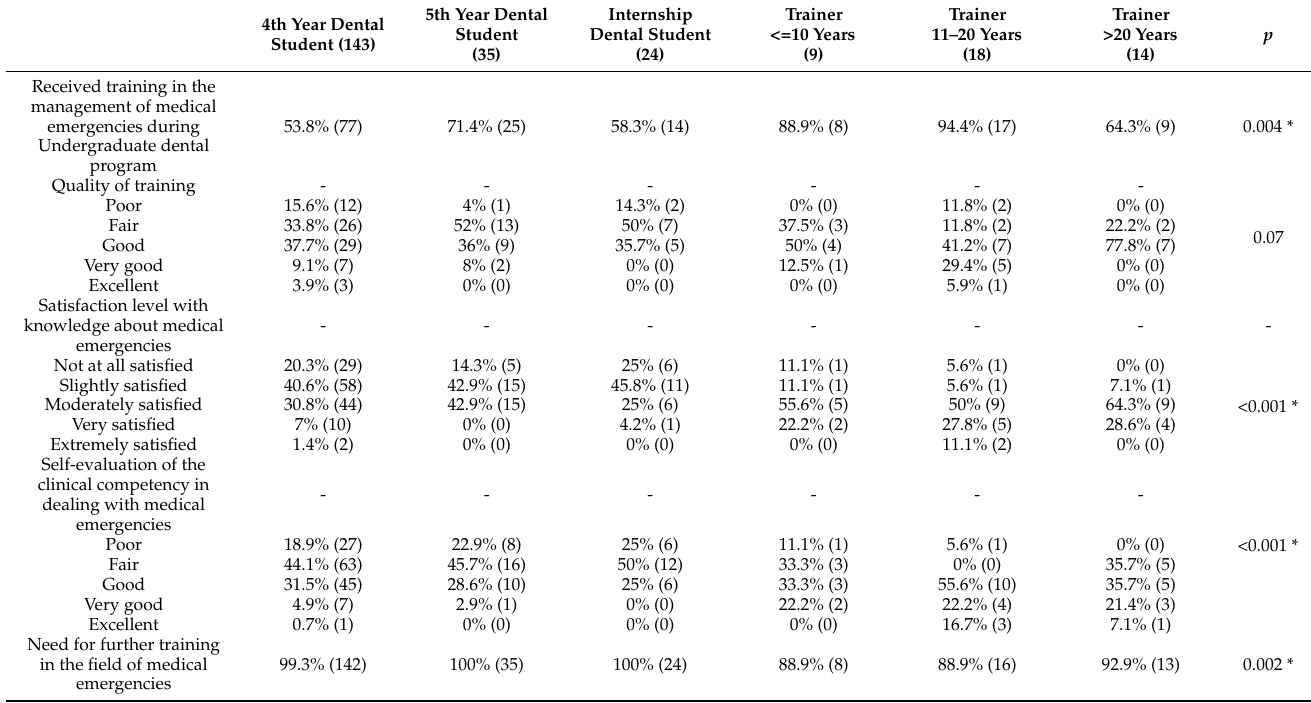
Table 4. Participants’ self-evaluation of their training, knowledge, and clinical competency in the management of medi- cal